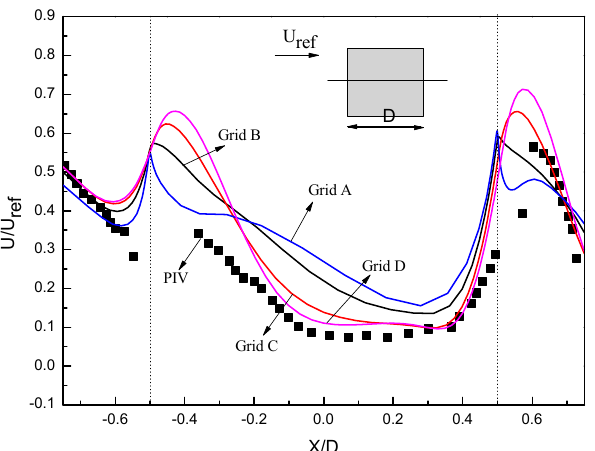
Figure 3. Grid sensitivity analysis and comparison between experimental and simulation results for the validation case.